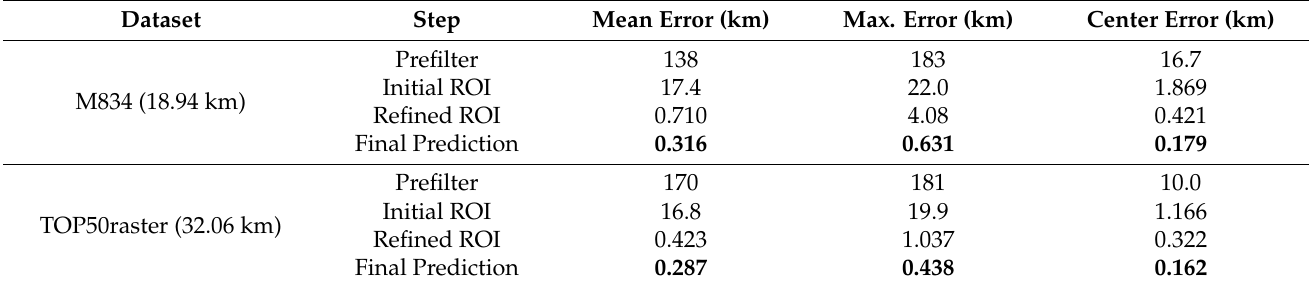
Table 1. Geolocalization results for both datasets, with the average map diagonal shown in brackets. The average mean error, maximum mean error, and average center error are presented for each step of the geolocalization algorithm. Prefilter details the result from Section 3.4, without the final clustering step. Initial ROI denotes the result after clustering and refined ROI denotes the result after outlier filtering with RANSAC.